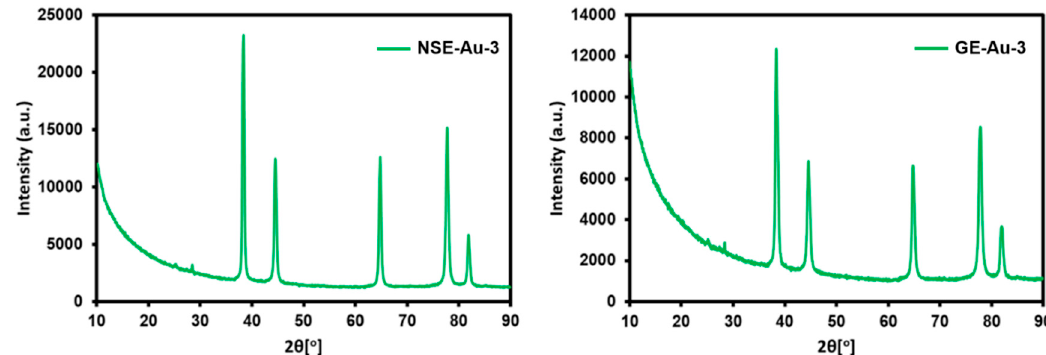
Figure 4. XRD pattern of gold nanoparticles (Au NPs) prepared by a using high concentration of both NSE and GE extract (20 mL in each case).